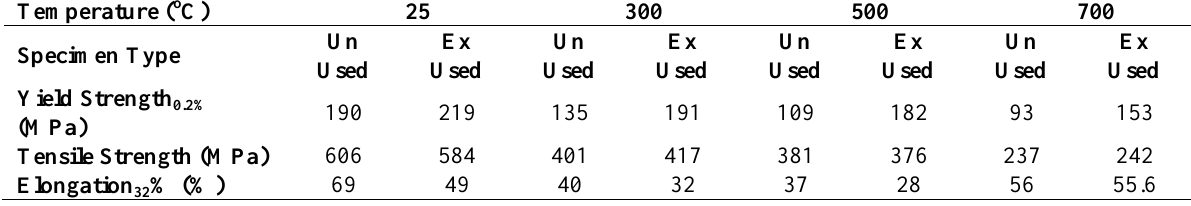
Mechanical properties for austenitic stainless steel 321H at different test temperatures.